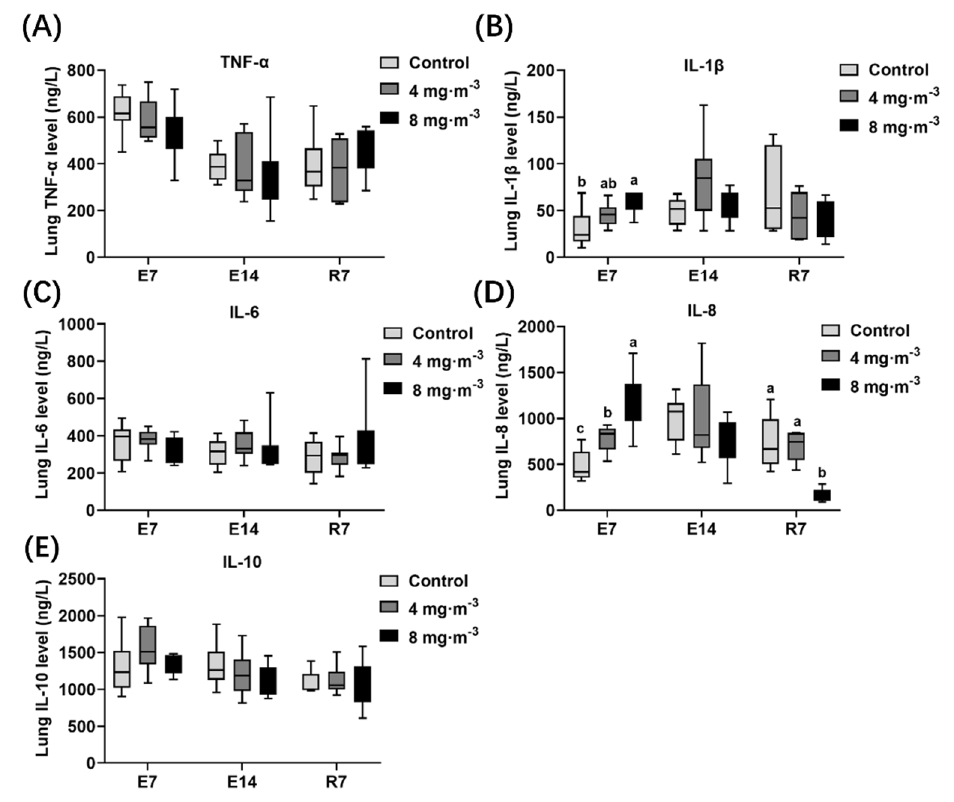
Figure 3. Effects of particulate matter exposure on inflammatory factor levels in lung of broilers. ( A – E ) represent the TNF-α, IL-1β, IL-6, IL-8, and IL-10 levels in lung tissue of broilers after E7, E14, and R7, respectively. Data are presented as mean ± SEM of groups (n = 8). Different letters indicate sta- tistically significant differences between groups ( p < 0.05). E7, exposure for 7 days; E14, exposure for 14 days; R7, recovery for 7 days.